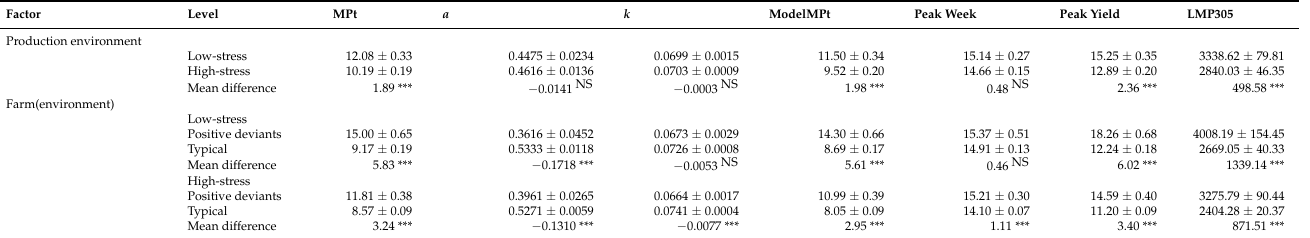
Table 2. Means (LSMEANS ± SE) of lactation curve parameters for Holstein–Friesian cows managed in positive deviants and typical farms nested within low- and high-stress production environments.